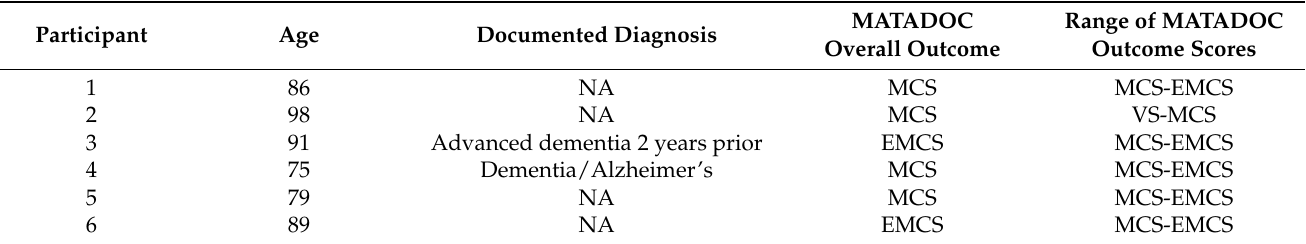
Table 2. Participant sample with range of MATADOC outcomes.